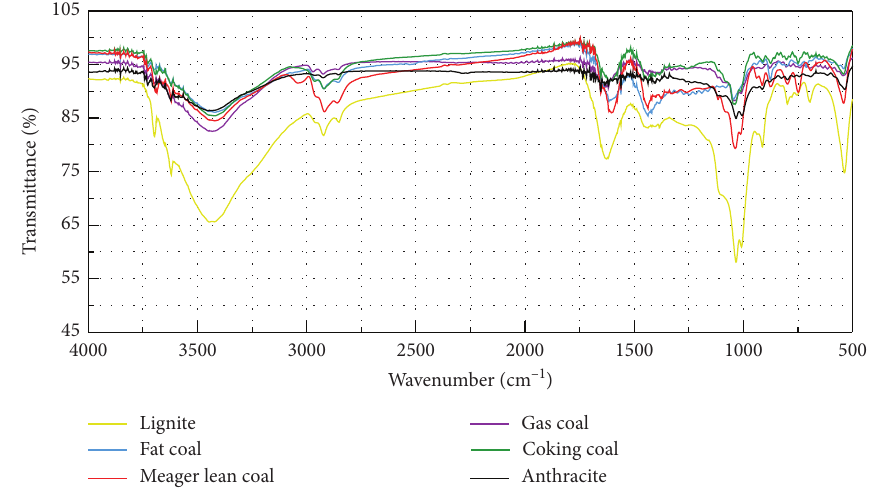
Figure 4: IR spectra of different coal dust samples.